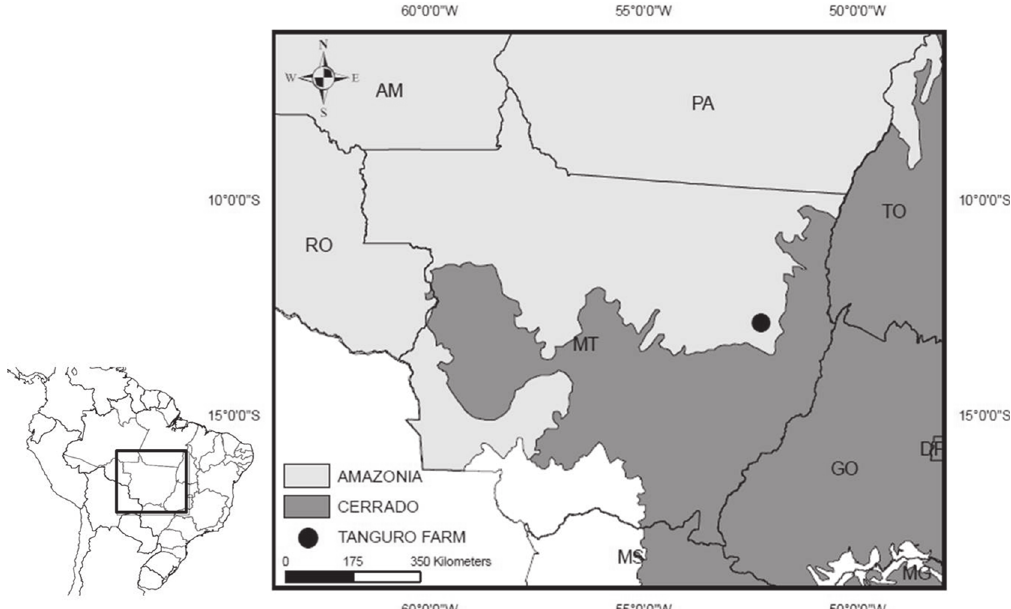
Figure 1. Location of the study area in the Brazilian state of Mato